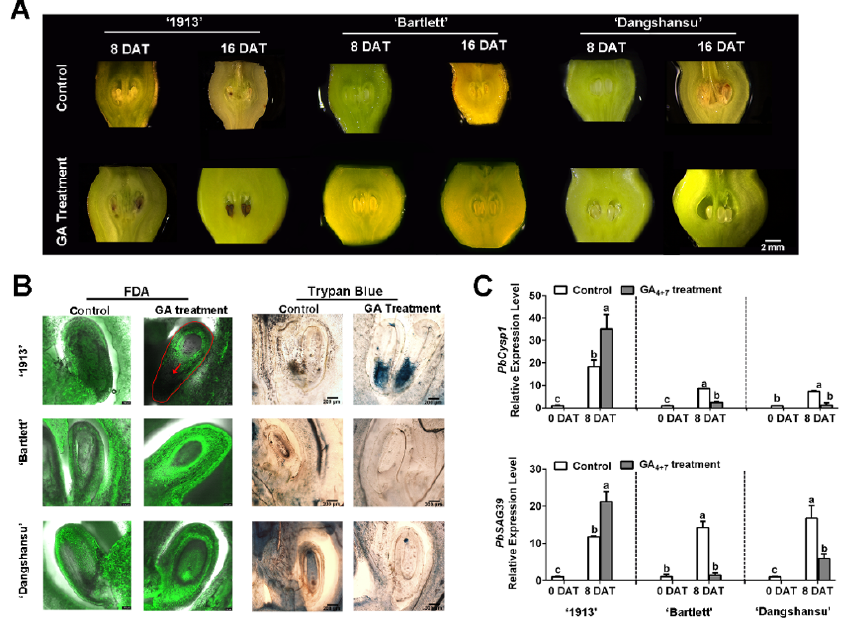
Figure 1. Ovule development of samples taken at 8 and 16 days after treatment (DAT) from ‘1913’, ‘Bartlett’ and ‘Dangshansu’. ( A ) Observations of ovule development at 8 and 16 DAT. ( B ) The ovules of 8 DAT from ‘1913’, ‘Bartlett’ and ‘Dangshansu’ were stained by FDA and trypan blue. ( C ) Expression profile of ovule senescence-related genes PbCysp1 and PbSAG39 in ovules of 0 and 8 DAT from ‘1913’, ‘Bartlett’ and ‘Dangshansu’. The sample of 0 DAT means the sample was collected before treatment. Control: unpollinated ovules with solvent treatment. GA Treatment: GA 4+7 treatment. The data are mean ± SD of three biological replicates. Error bars represent the standard deviation. Different lowercase letters indicate significant difference at p < 0.05 (Duncan’s multiple range test).